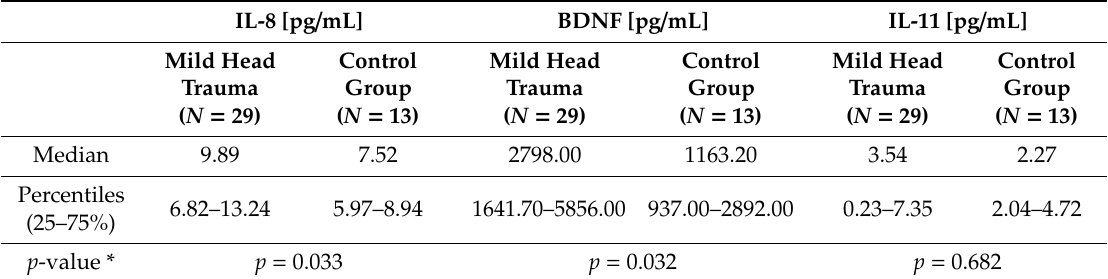
Figure 2. Brain-derived neurotrophic factor (BDNF) concentration in the total group of children with mild head trauma compared to the control group. Table 1. IL-8, BDNF and interleukin-11 (IL-11) concentration in children with mild head trauma compared to the control